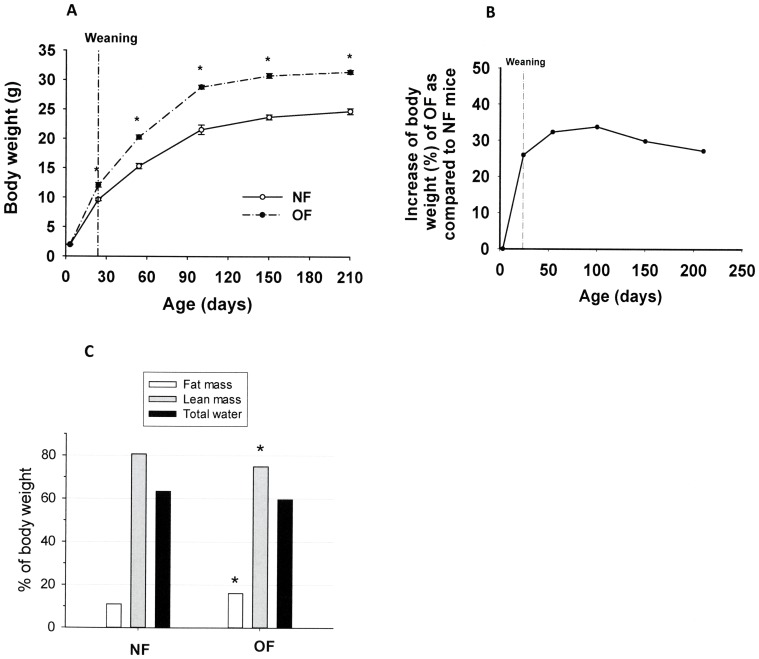
Increase in body weight and body composition during life in mice postnatally overfed (OF) by litter size reduction (3 pups/litter) or normally fed (NF) in litters of normal size (10 pups/litter).A: Body weight from birth to 210 days (7 months) of OF and NFmice. Results are expressed as means ± SEM. *, P<0.05 was considered significant (one-way ANOVA). B: Percentage of mean body weight increase in OF mice as compared with that in NF mice. C: Body composition (fat mass, lean mass and total water), measured by nuclear magnetic resonance, as a percentage of body weight in OF mice and NF mice. *, P<0.05 was considered significantly different. Data are expressed as means ± SEM from 10 animals per group.